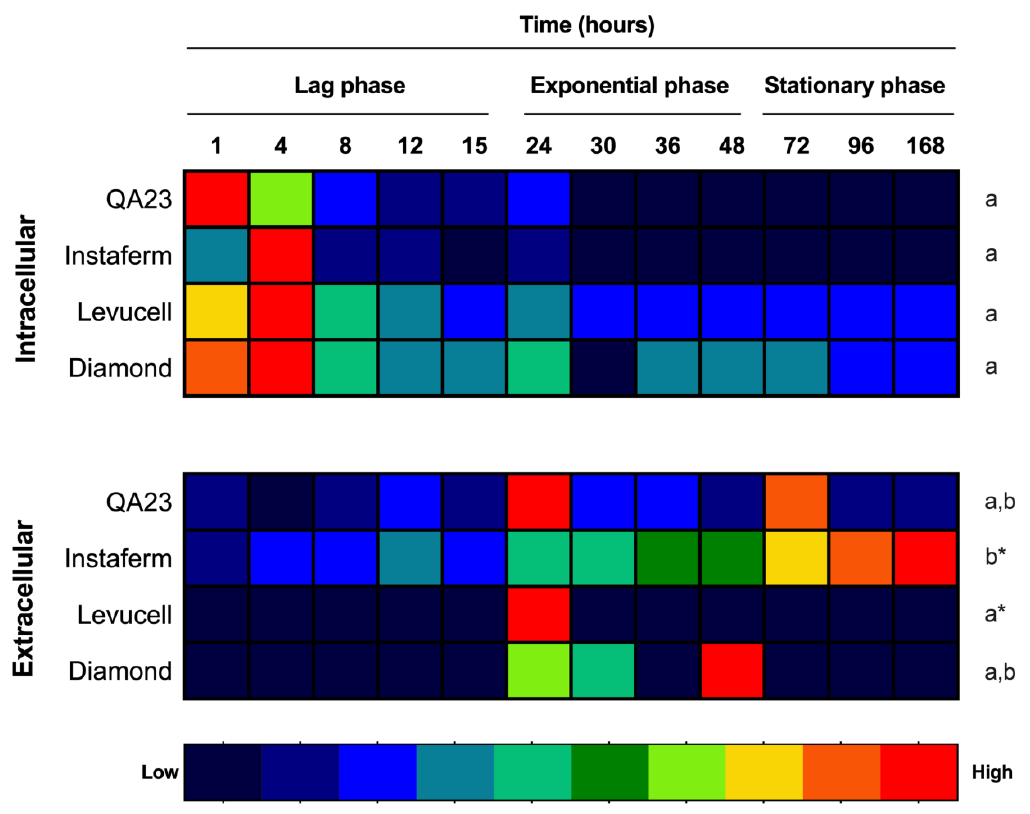
Figure 2. Heatmap of melatonin production by the four Saccharomyces strains during the different yeast growth phases. Concentrations were normalized to its maximum level. Different letters indicate significant differences between conditions within each strain, p < 0.05.